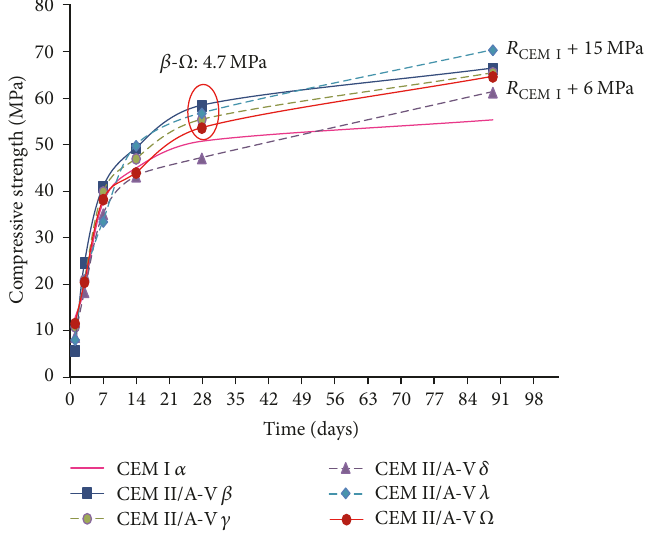
Figure 2: CEM II/A-V compressive strength